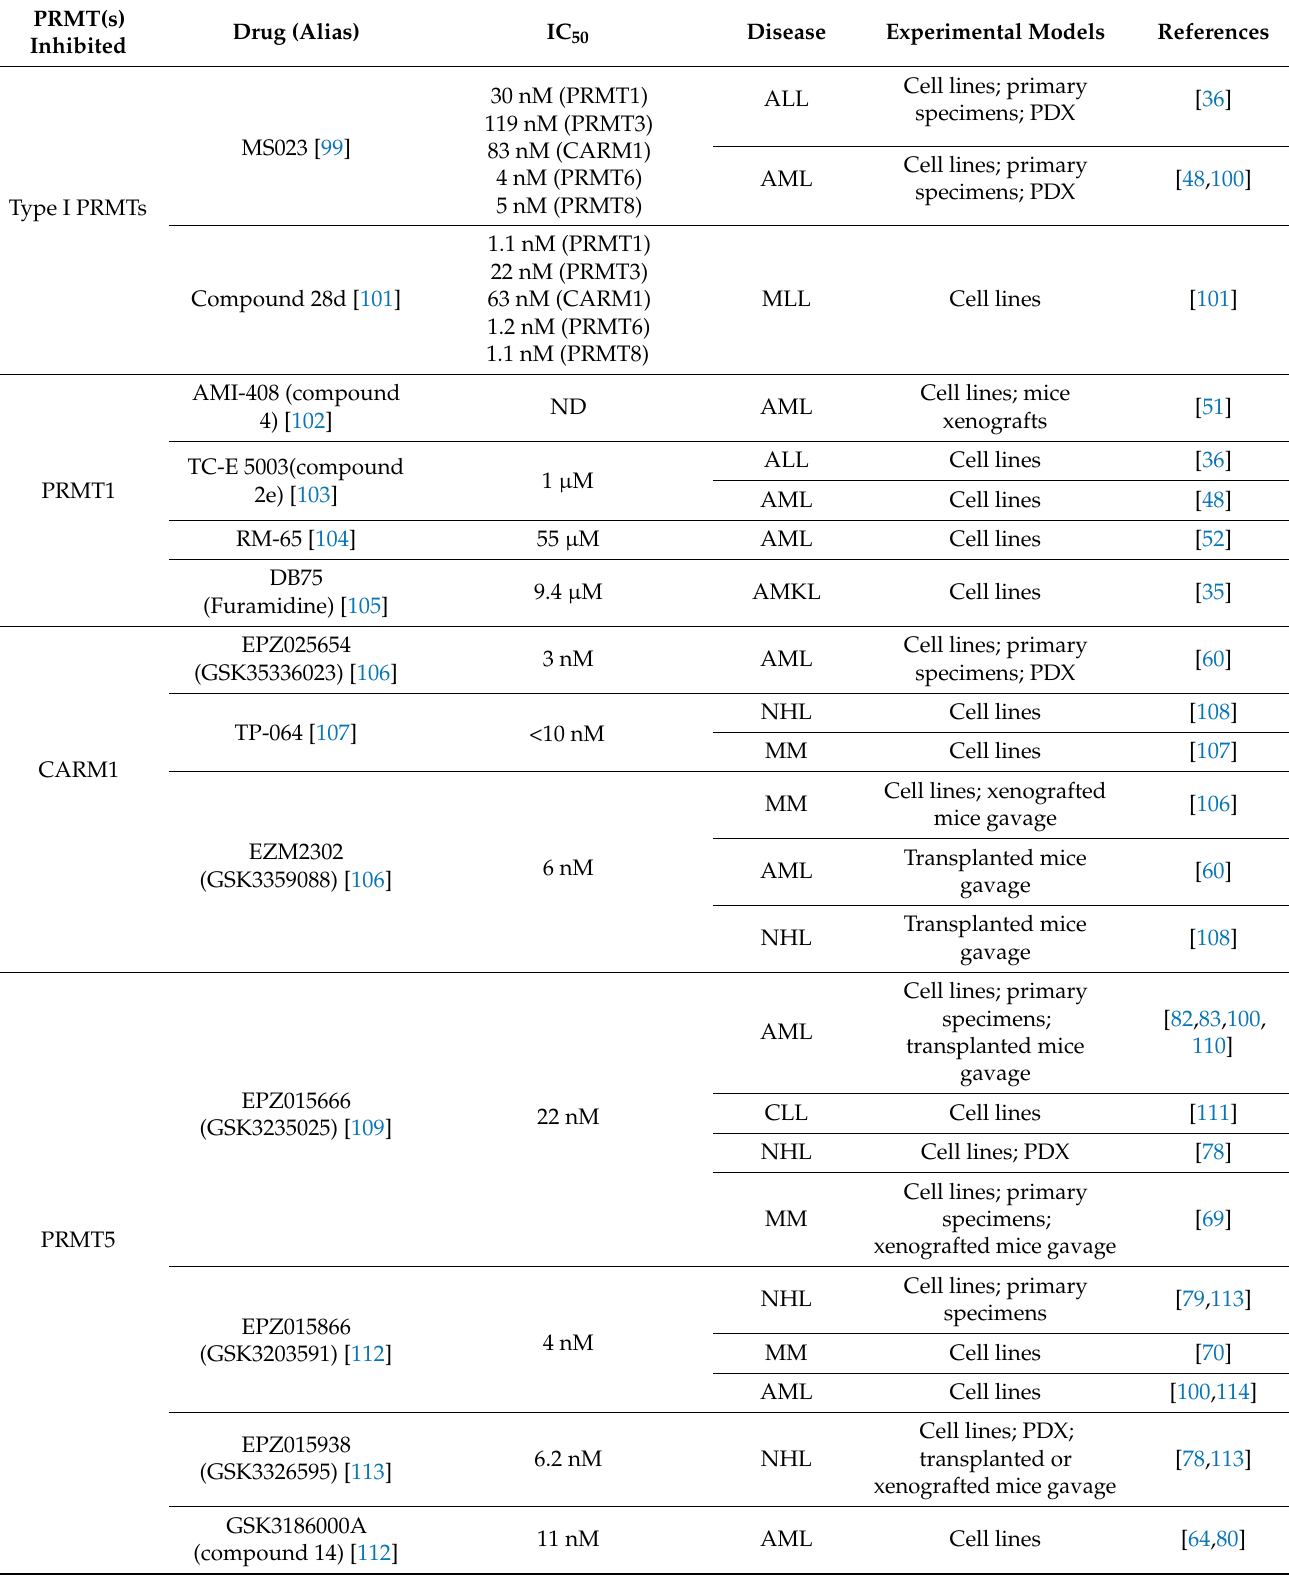
Table 1. Tool compounds for PRMT inhibition in hematological